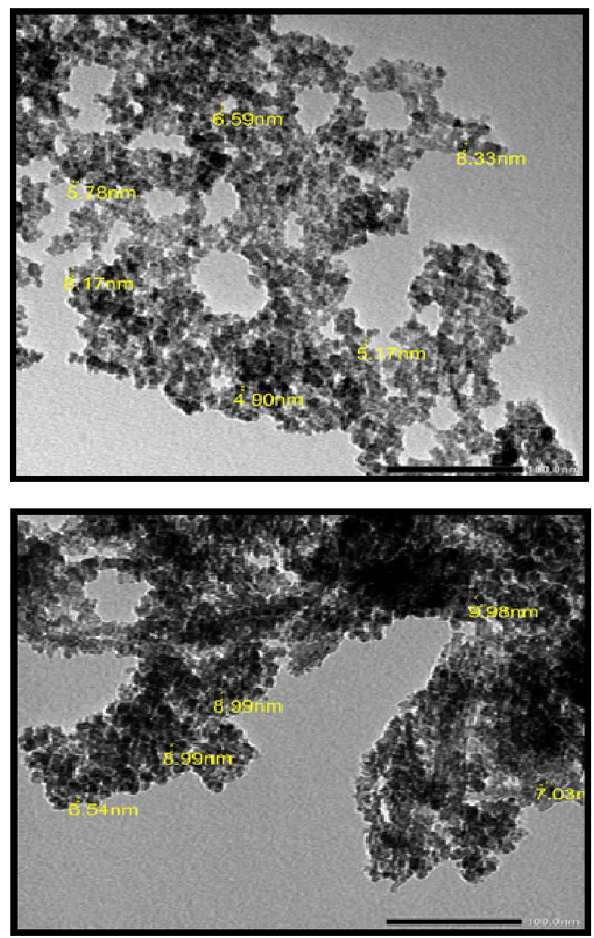
Figure 4. TEM image of Fe 0.75 Cu 0.25 -BDC@Alg-MoO 3